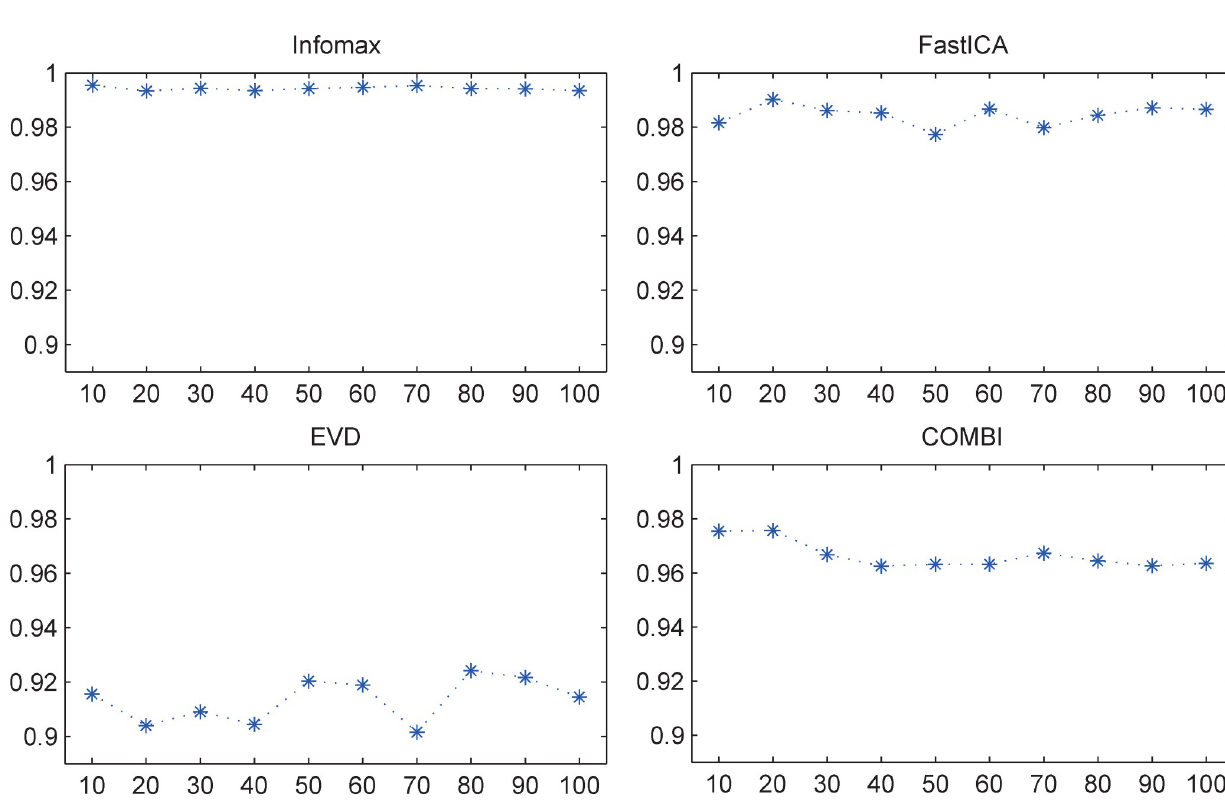
Fig 2. Median Iq values of different results for non-deterministic ICA (motor data). The unit of the x-axis is the ICASSO repetition number k, and the unit of the y-axis is the Iq value. https://doi.org/10.1371/journal.pone.0270556.g002 Table 3. Repetition number k did not influence Iq values for non-deterministic ICA (motor data). Infomax FastICA EVD